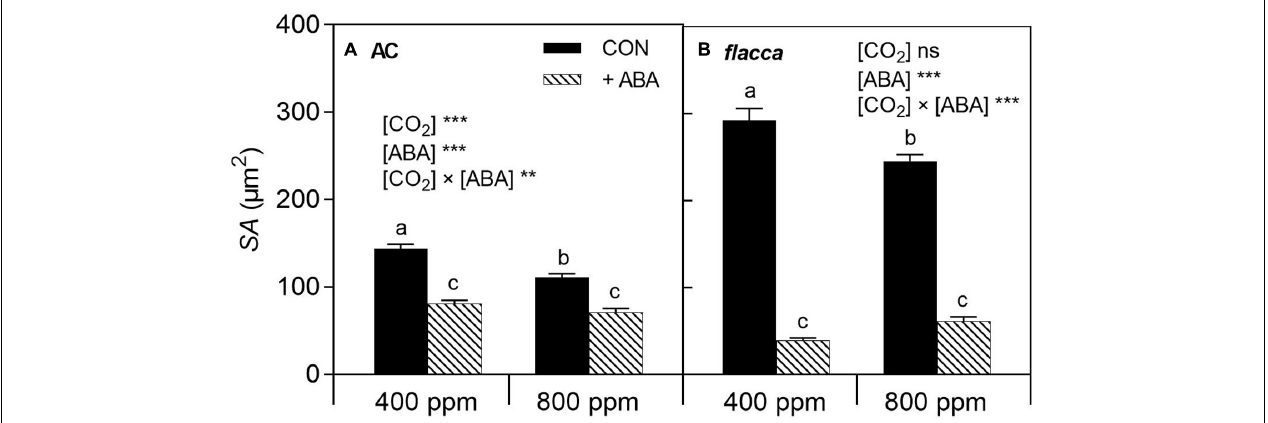
FIGURE 2 | Stomatal pore aperture ( SA ) of AC (A) and flacca (B) grown under ambient (400 ppm) and elevated (800 ppm) CO 2 concentrations 1 day after exogenous ABA application. CON indicates the control treatment sprayed with water, +ABA indicates exogenous ABA application. Different letters on the top of the columns indicate a significant difference between the treatments by Tukey’s test at p < 0.05. ** and *** indicate the significant differences between [CO 2 ] and without or with exogenous ABA application ([ABA]) in two-way ANOVA at p < 0.01, p < 0.001, respectively; ns denotes no significant difference. Error bars indicate the standard error of the means (S.E.) ( N =